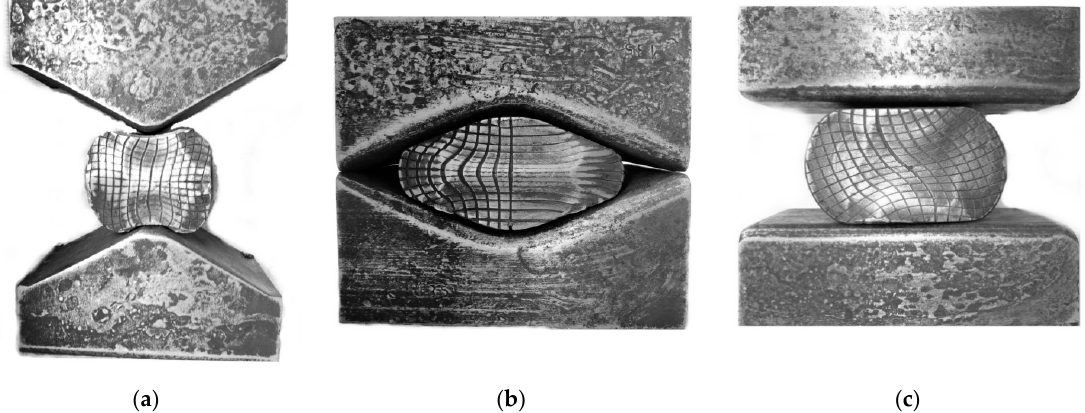
Figure 23. Shape of the anvils used in the laboratory experimentation: ( a ) convex ( α c = 135°), ( b ) V-shaped ( α = 140° × 140°), and ( c ) flat.